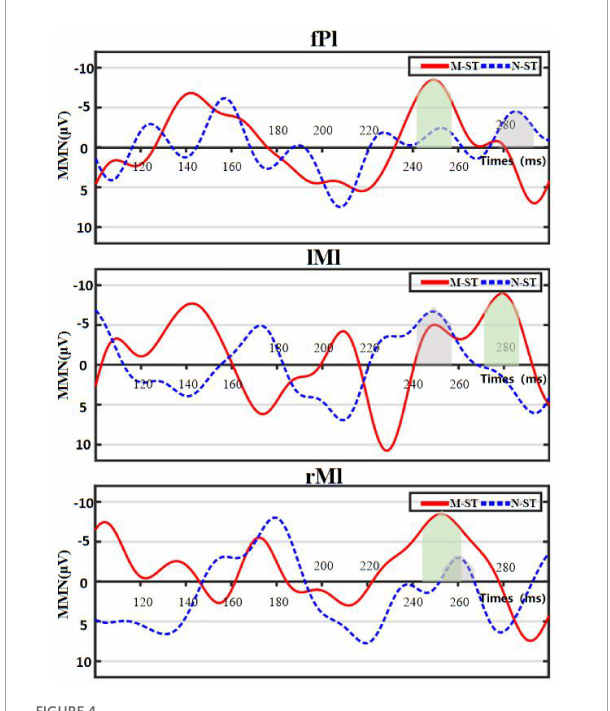
FIGURE4 Figure of mean distribution of MMN. "fPl" represents the prefrontal parietal lobe area, "lMl" represents the left motor cortex, and "rMl" represents the right motor cortex. The red solid line represents the MMN value of group “M-ST”, and the blue dotted line represents the MMN value of group “N-ST”. The light green area and the light gray area represent the superposition range of MMN statistical values of group “M-ST” and group “N-ST”, respectively.